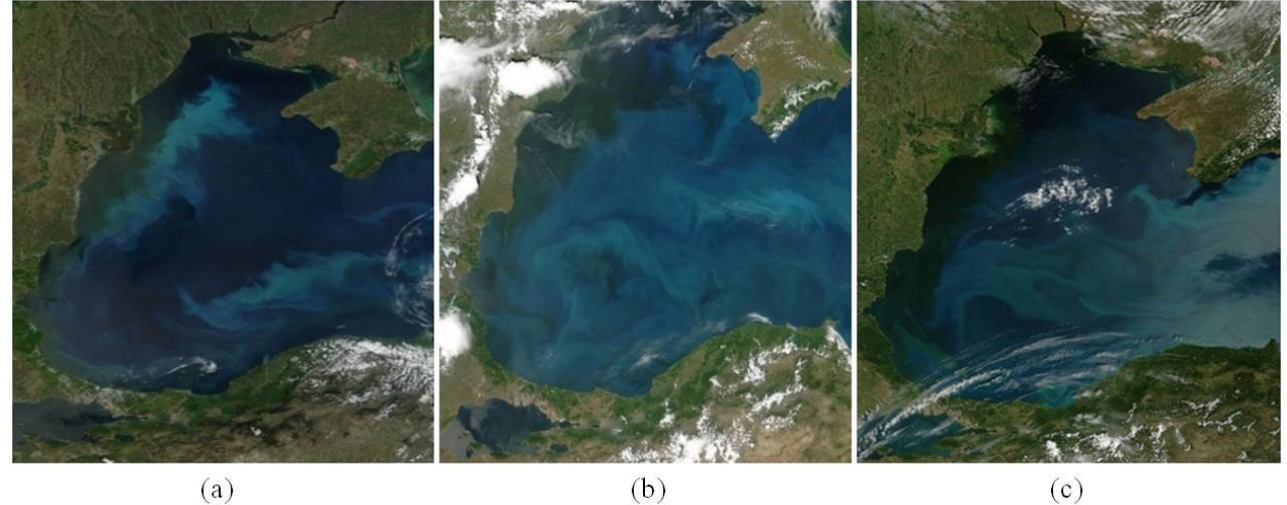
Figure 12. Summer blooms of coccolithophores in the western part of the Black Sea in 2002 (10 May 2002) ( a ), 2006 (20 June 2006) ( b ), and 2012 (18 June 2012) ( c ) Source (https://visibleearth.nasa.gov, accessed on 15 December 2021).